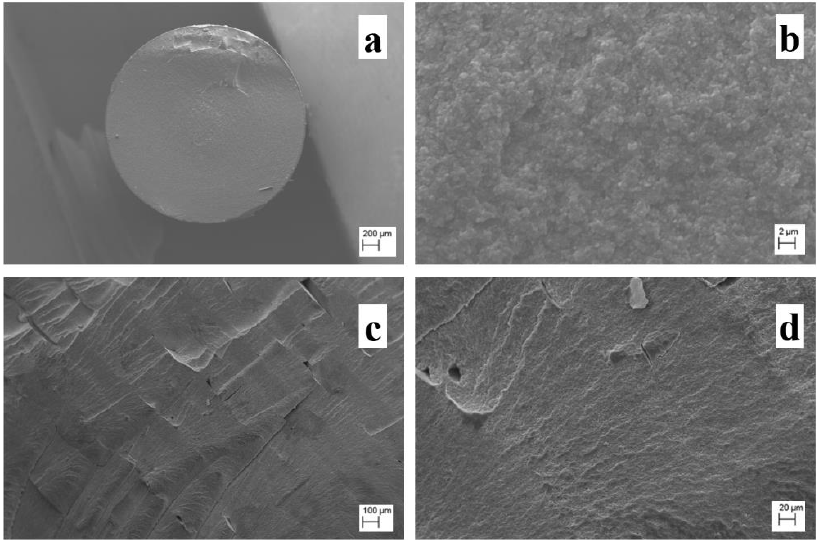
Figure 3. SEM images of: filament at magnifications of ( a ) 50 × and ( b ) 5k × ; green parts at magnifica- tions of 100 × ( c ), and 500 × ( d ).